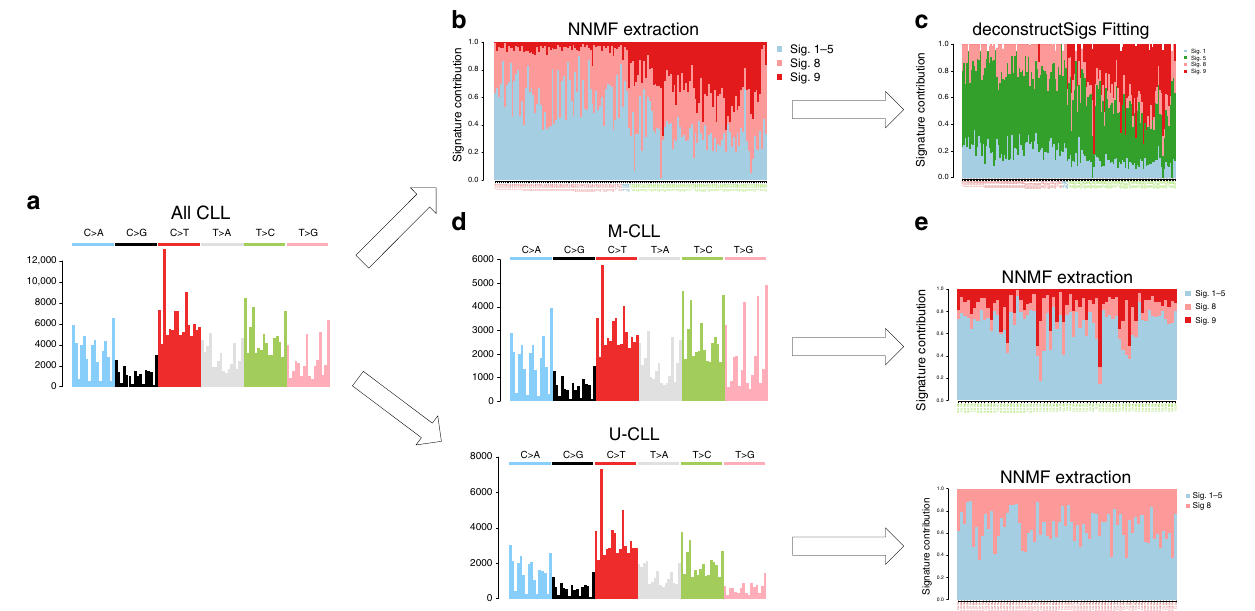
Fig. 6 Bleeding of signatures in CLLs. Summary of mutational signature analysis on 146 CLL cases. From the 96-mutational catalog ( a ) the Alexandrov et al. 6,7 framework (NNMF) extracted different mutational processes. Signature 9 (nc-AID) was extracted also among U-CLL in contrast with their known pathogenesis ( b ). This is a typical example of inter-sample bleeding and it can be solved either running a fi tting approach after the initial NNMF analysis using only the catalog of signatures extracted by NNMF ( c ), or analyzing M-CLL and U-CLLs in two different and independent runs ( d , e ). Using the 30 COSMIC signatures as reference, the fi rst approach is usually the most appropriate in order to estimate the real contribution of each single mutational process. In fact, the NNMF extracted signatures may be over or under split, therefore preventing a precise estimation of their contribution. For example, in this analysis, Signature 1 and 5 were extracted as one single process and only by running a fi tting approach we were able to differentiate these two processes ( c ). Sig. = signature. In b and c , red patient labels are used for U-CLL, green for M-CLL, and blue for unknown